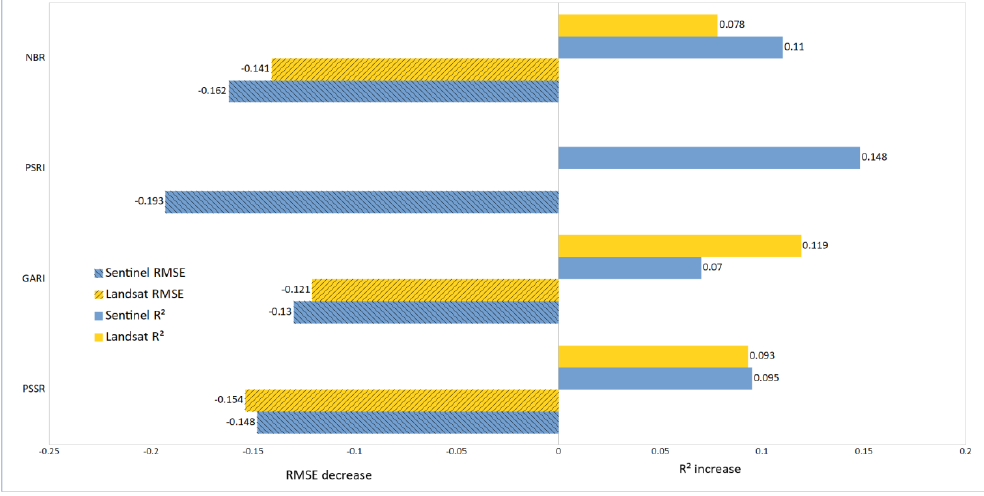
Figure 6. E ff ect of removing plots with a dense shrub layer on LAI e model RMSE and R 2 for the best-performing Landsat-8 and Sentinel-2 vegetation